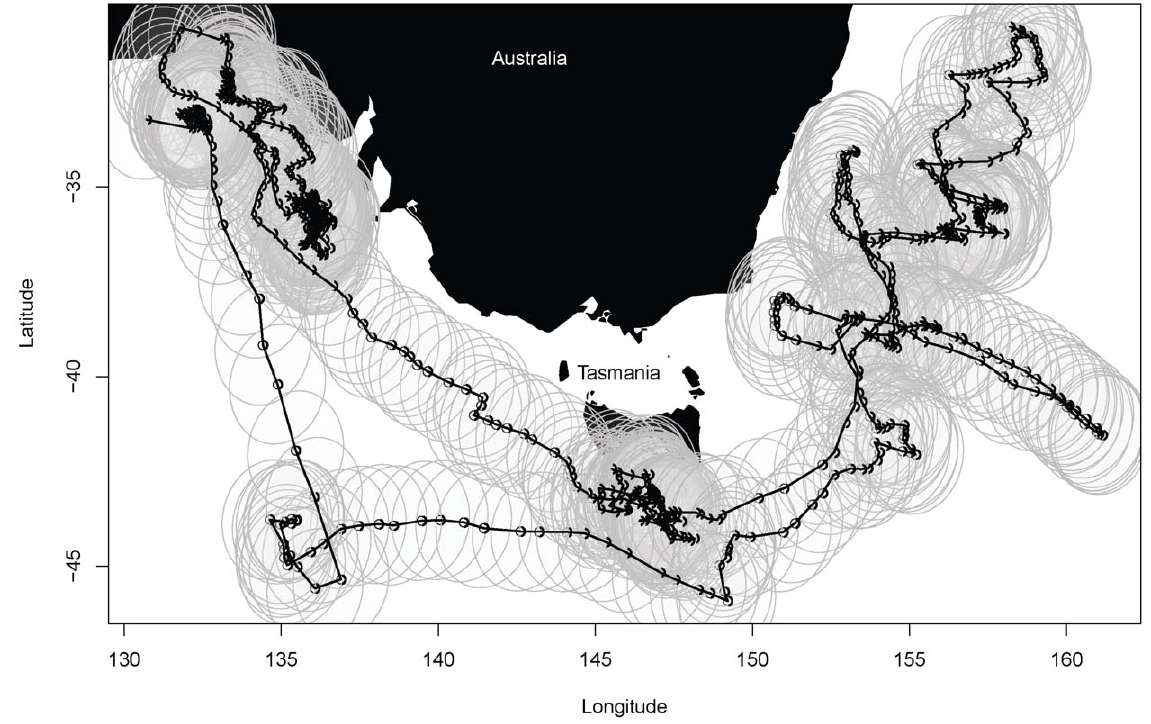
Figure 1. An example of movement data obtained from a data storage tag deployed on a tuna (CSIRO unpublished data). The Location estimates were derived from the state-space model approach developed by [25]. This method yields a point-estimate along with error- variances from the 95% error ellipses depicted here were derived. Associated with this track are records of temperature-at-depth recorded every minute over a period of approximately 12 months (data not shown).